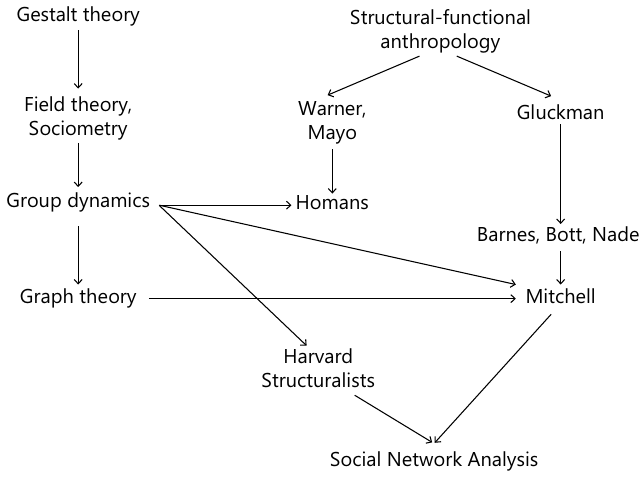
Fig. 1. The lineage of social network analysis Source : Scott